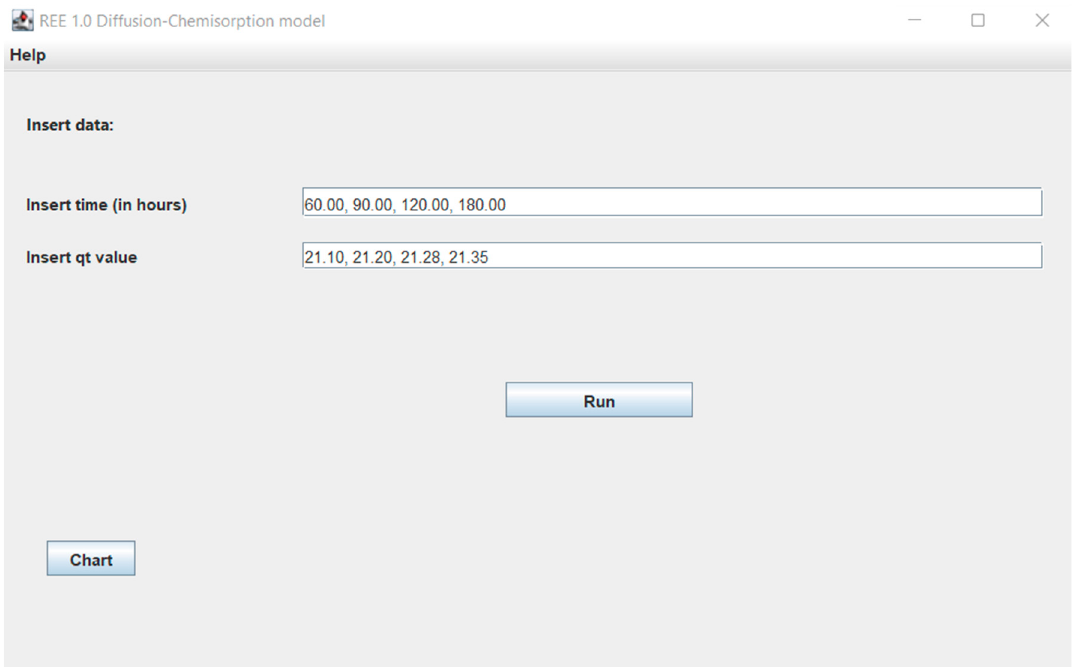
Figure 2. Window with diffusion-chemisorption model experimental data results for Eu ions.